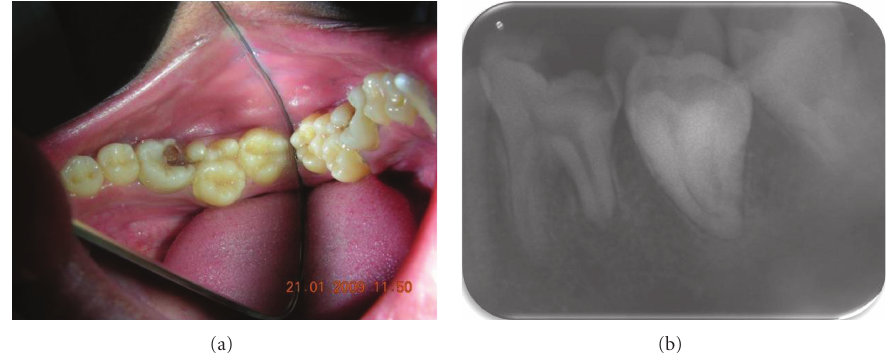
Figure 1: (a) Pre-operative photograph: Occlusal View. (b) Pre-operative radiograph revealing irregular morphology of tooth #20 & istal root resorption with